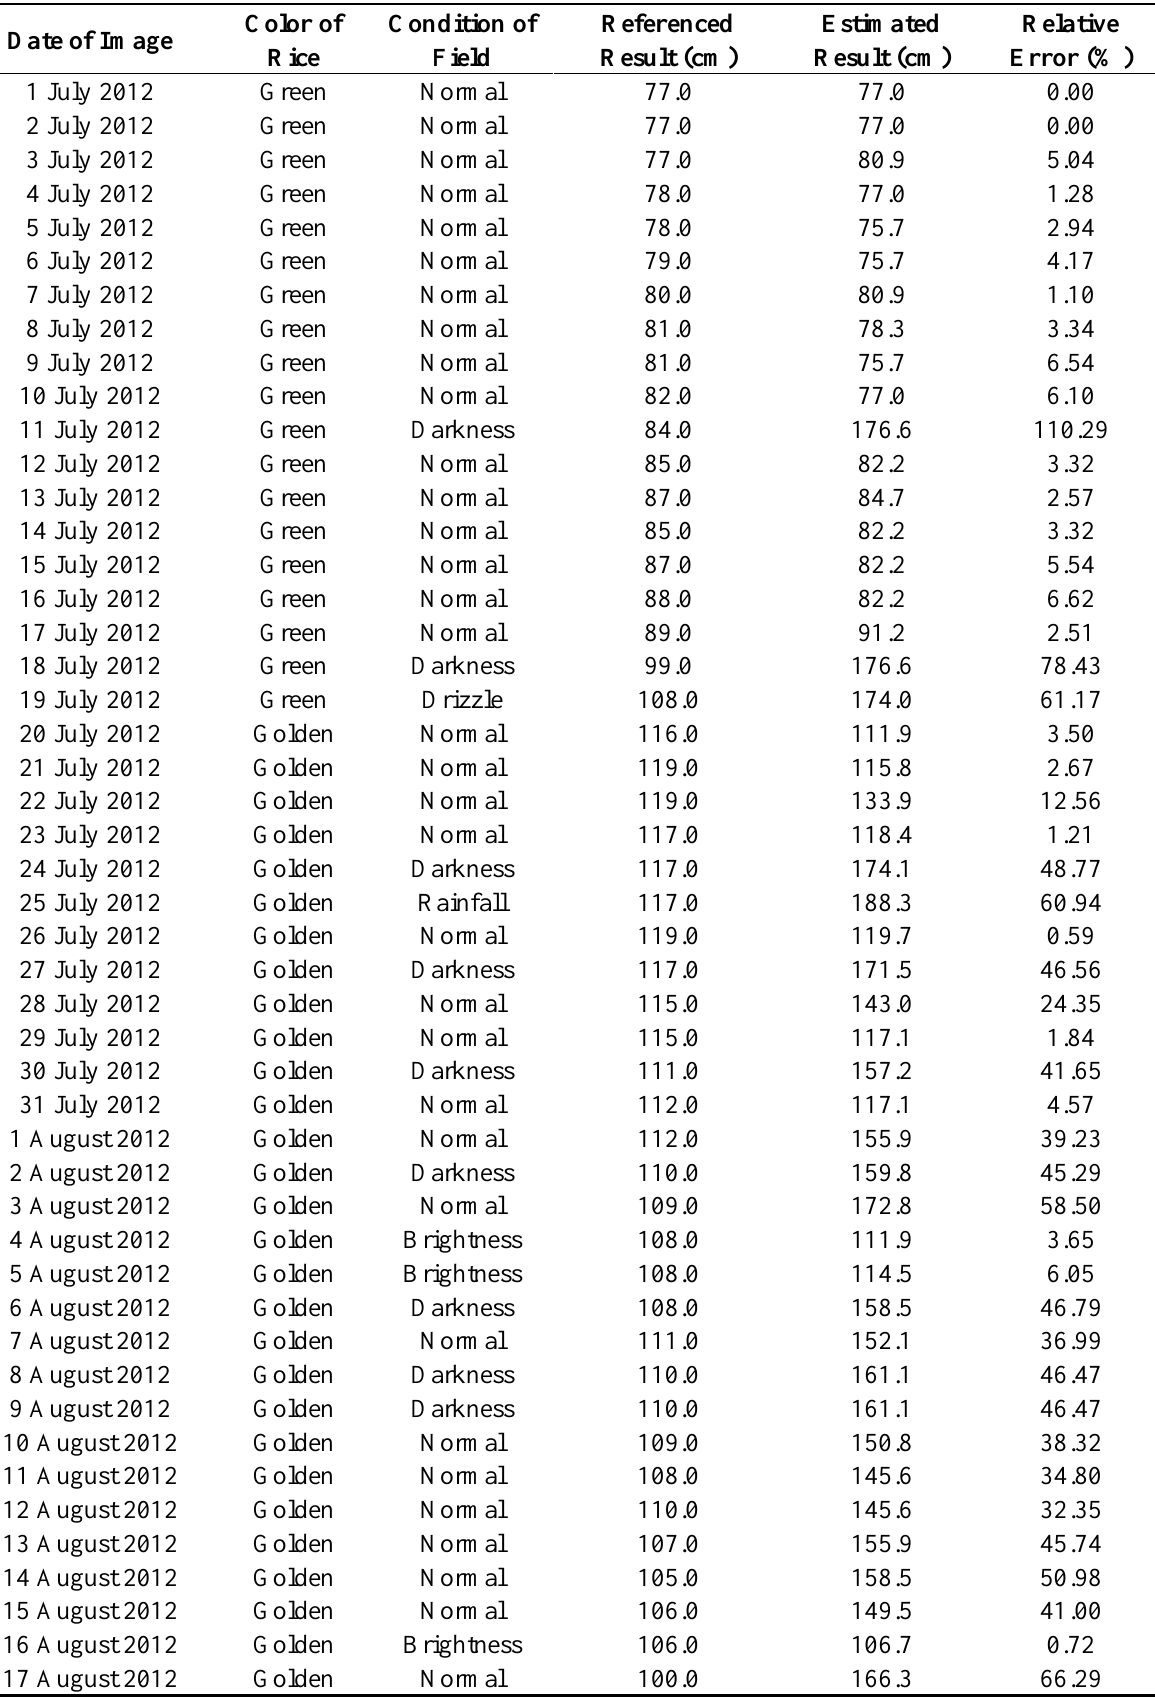
Table 1. Comparison between estimated results using red band feature and referenced